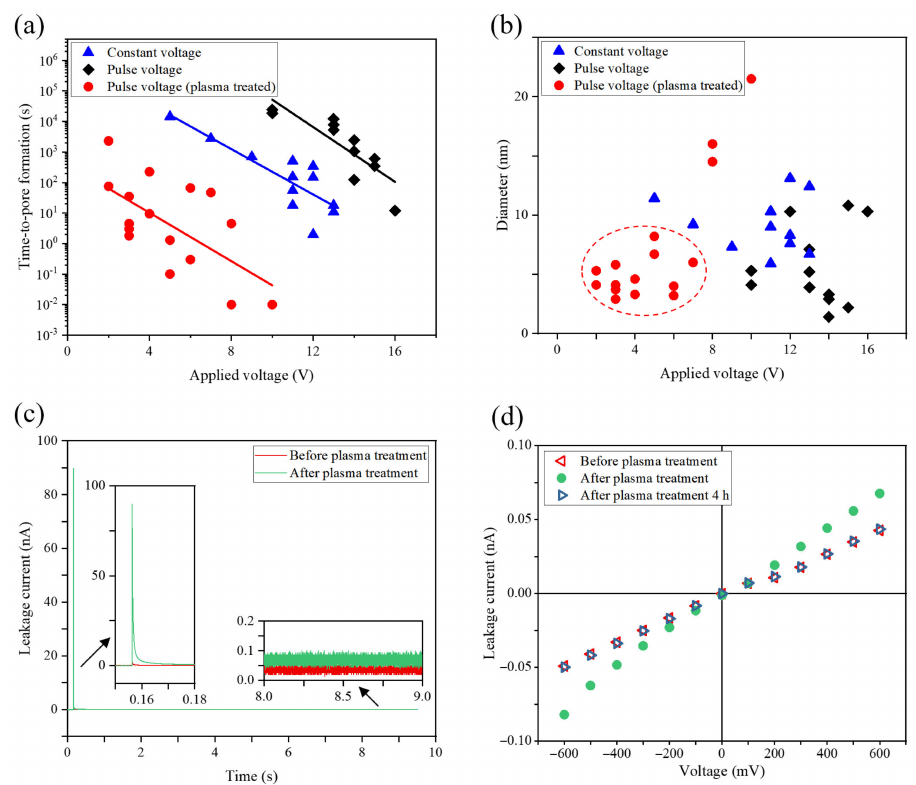
Figure 2. ( a ) Semi-log plot of time-to-pore-fabrication as a function of applied voltage for nanopores fabricated in 20 nm-thick SiN x membranes in 1 M KCl solution; ( b ) scatter plot of pore diameter versus applied voltage; ( c ) leakage current trace of a SiN x membrane before and after plasma treatment at a 600 mV applied voltage; ( d ) I–V curves for the SiN x